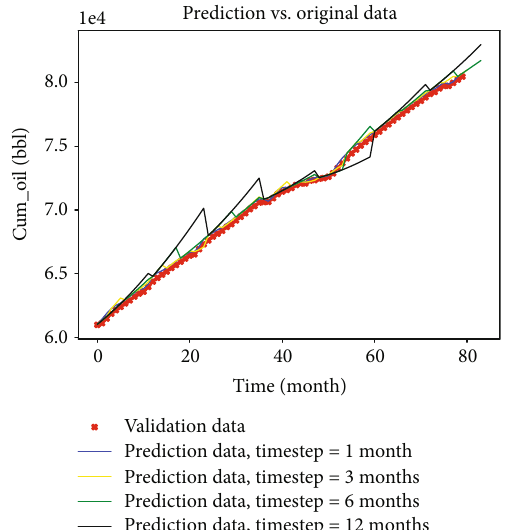
Figure 7: Cross-plot of prediction and cumulative oil data in Bakken formation. The scale of the x - and y -axes is in an order of 10 4